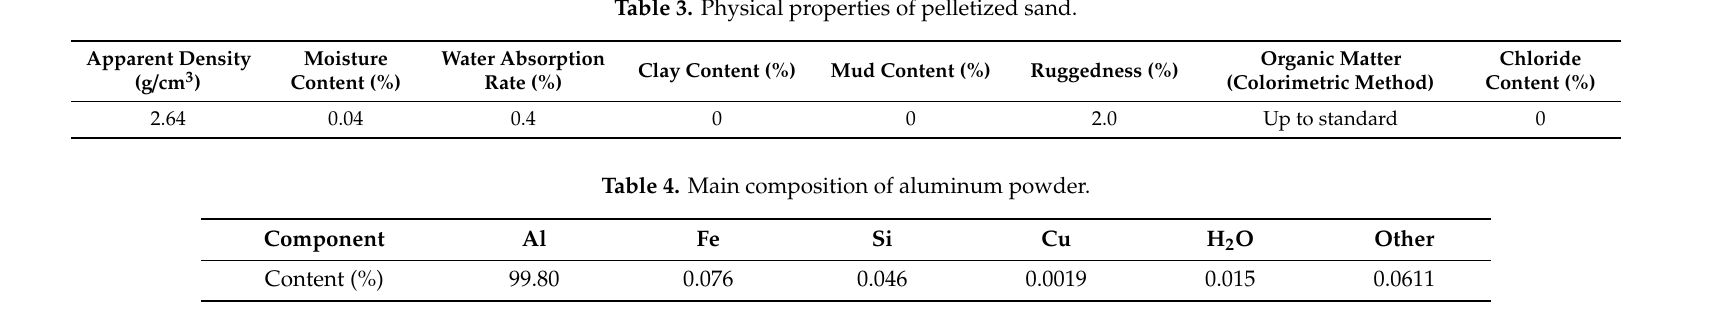
Table 5. Mix proportion of cement emulsified asphalt (CA)